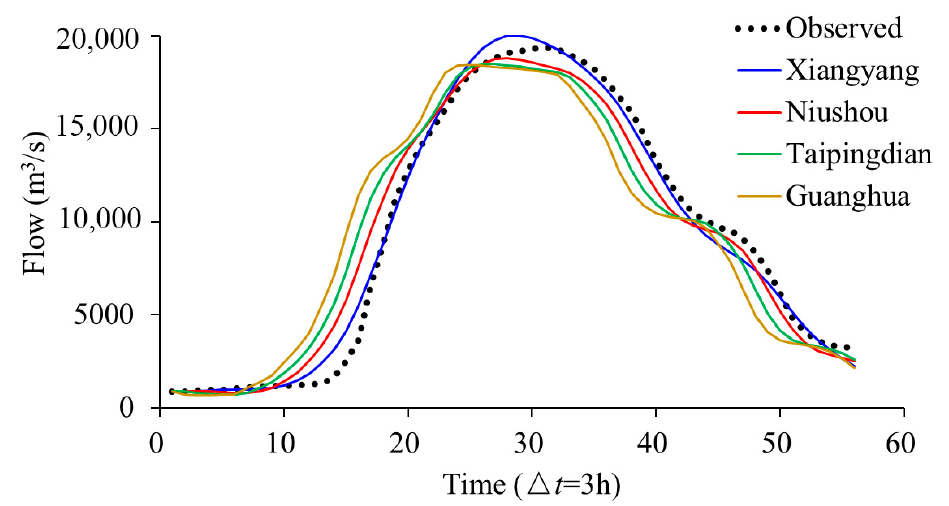
Figure 4. Flood hydrographs of sections between Huangjiagang and Xiangyang.